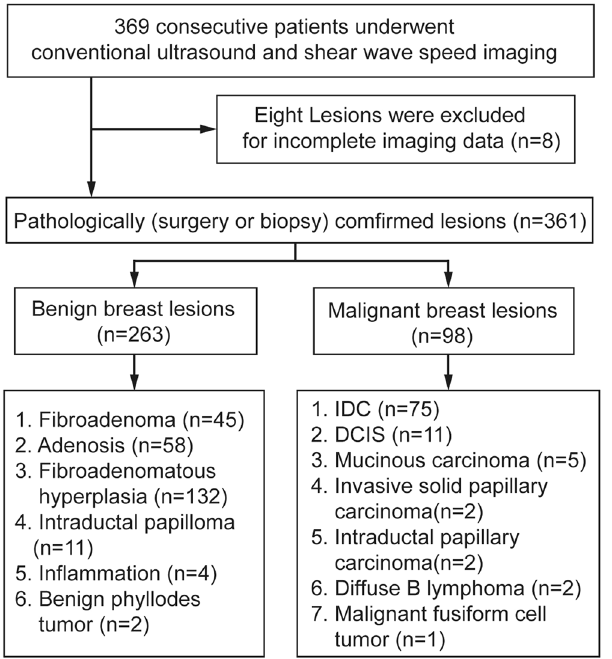
Figure 1. Flowchart of breast lesions selection. IDC = Infiltrating ductal carcinoma; DCIS = Ductal carcinoma in